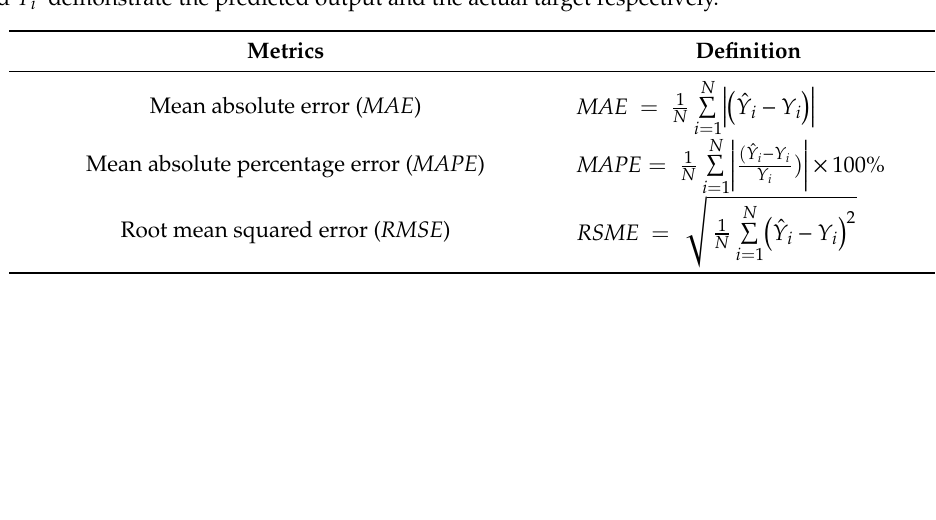
Table 5. List of metrics used for evaluating model performance. N defines observations’ number, ˆ Y i and Y i demonstrate the predicted output and the actual target